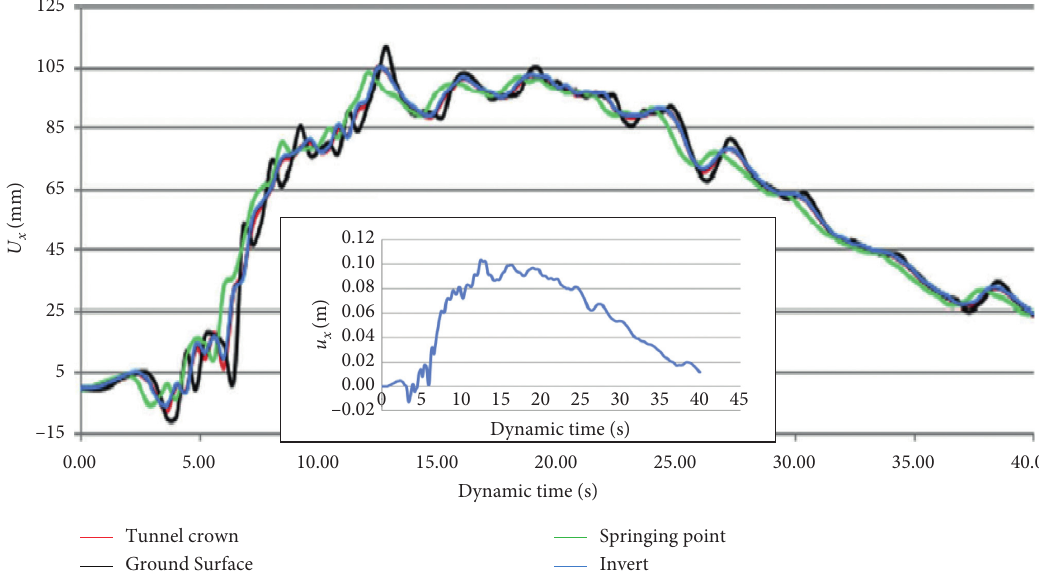
Figure 4: Verification time history analysis with article (Singh et al. 2016) in the Abaqus for horizontal displacement on the tunnel crown.